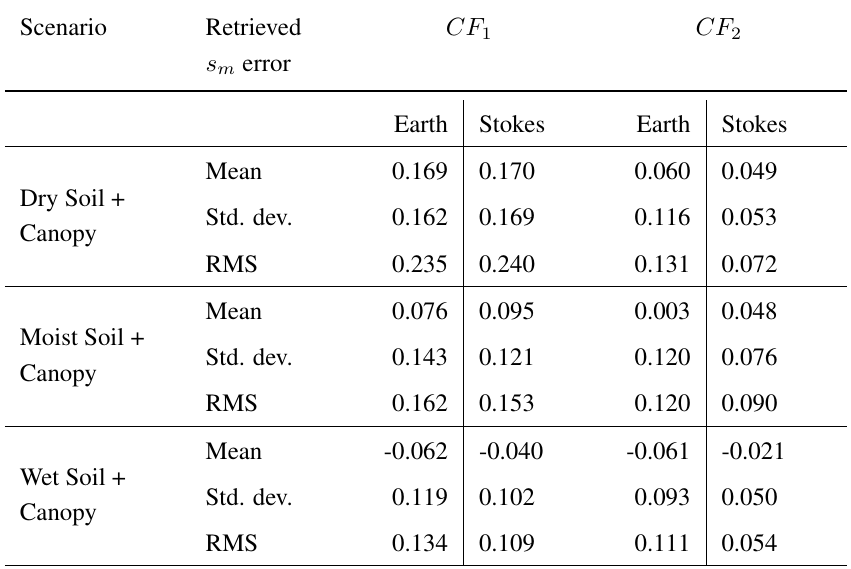
Table 4. Retrieved mean, standard deviation and root mean square soil moisture error of simulated SMOS observations over the vegetation-covered scenarios on Table 1, using the cost function configurations of Table 2, formulated on the Earth reference frame or using the first Stokes